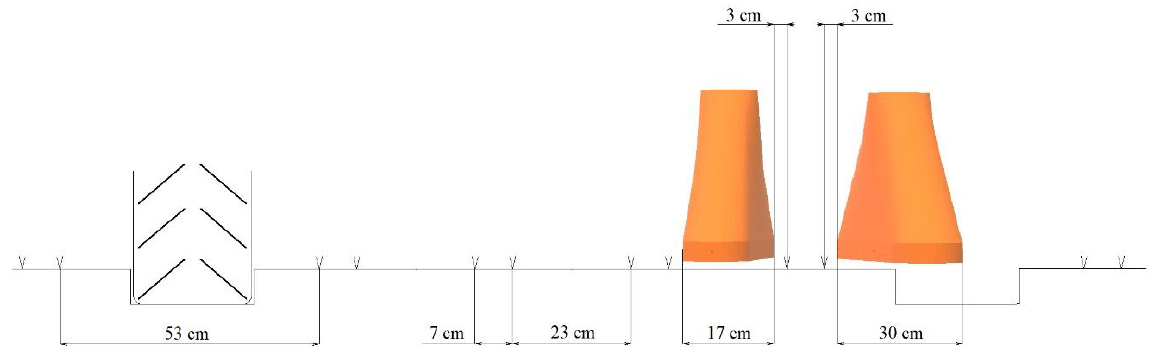
Figure 2. The width of sprayed strips and the arrangement of spraying sections in strip-row onion cultivation (source: own work).